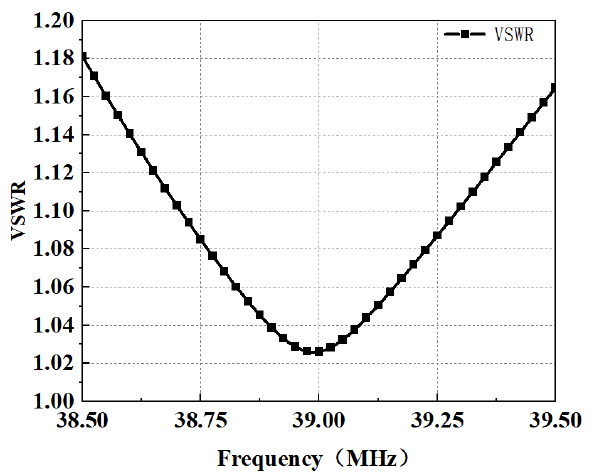
Figure 4. The simulated VSWR of the designed turnstile antenna.